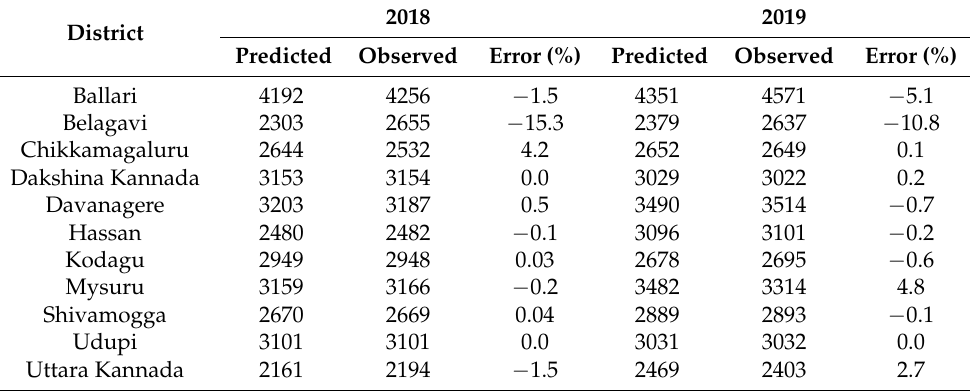
Figure 6. Graphical representation of the established neural network for rice yield forecasting Z indicates the weather indices used for the forecast; Ref. Table 2. Table 7. District-wise error percentage of Kharif rice yield (Kg/ha) forecasted using artificial neural network (ANN) during 2018 and 2019.